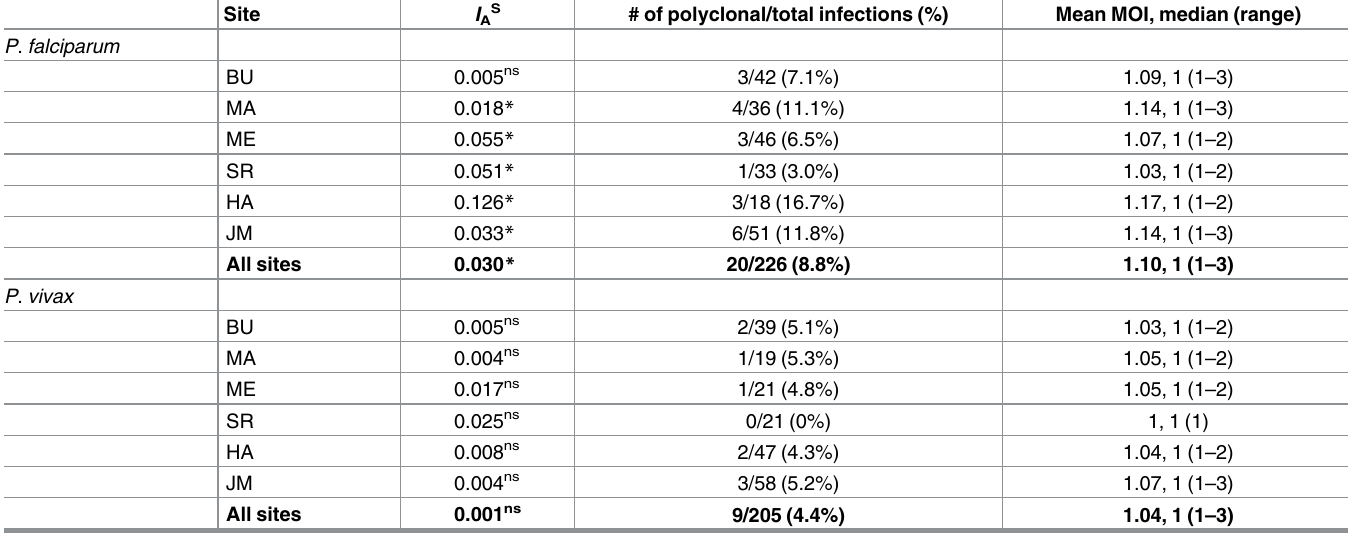
Table 1. Linkage disequilibrium and complexity of infection among P . falciparum and P . vivax samples by study sites. ‘ns’ denotes non-significant; ‘ * ’ denotes P <